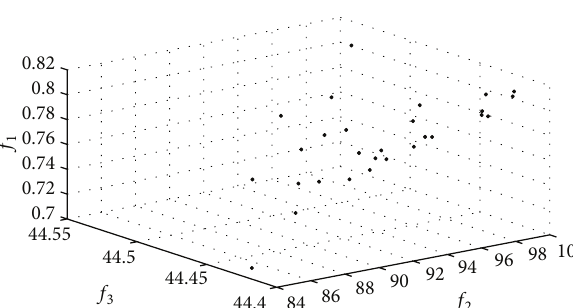
Figure 6: The Pareto frontiers of the CPSO algorithm.